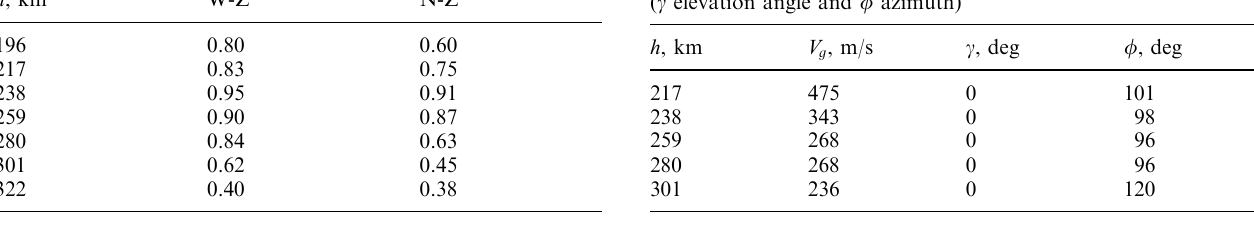
Table 1. Cross-correlation coe(cid:129)cient for positions Z, W, and N near the time of ST passage h , km